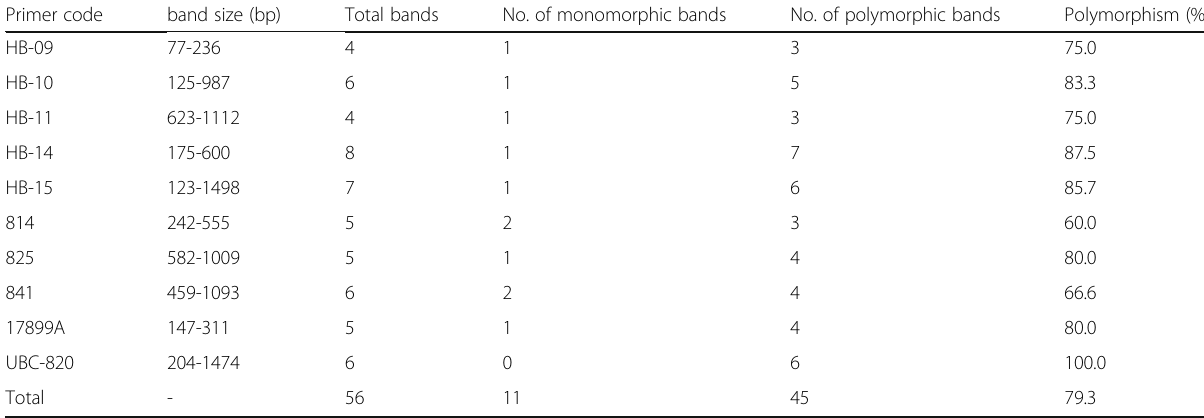
Table 6 Total bands, number of monomorphic and polymorphic bands, and the percentage of polymorphism of the 14 studied samples of Silybum marianum generated by ten ISSR primers Primer code band size (bp) Total bands No. of monomorphic